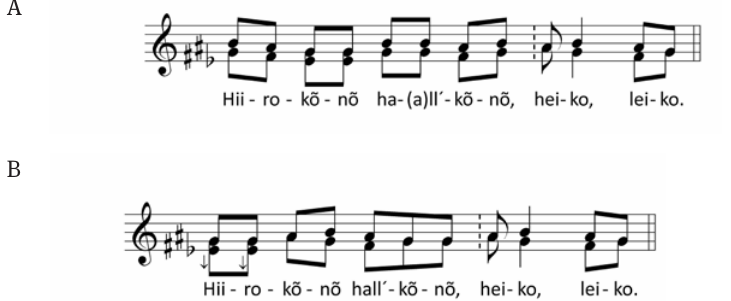
Figure 5: The even verse sung with 8 isochronous notes (5a) and the interpretation of that verse using the method of shorte- ning: the Q2 word occupying the 5th and the 6th position is sung half shorter (5b). 5a – The choir of Olga Ohtla, 5b – The choir of Natalia Rahasepp, ’You are moving towards the platter of honour’.